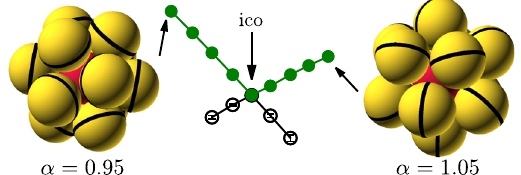
FIG. 3. Variants of the icosahedral cluster for slightly aspherical ellipsoids. Left picture: Neighbors squashed in the normal direction, leading to oblate ellipsoids. Right picture: Neighbors expanded in the tangential direction, leading to prolate ellipsoids. The center plot magnifies Fig. 2.